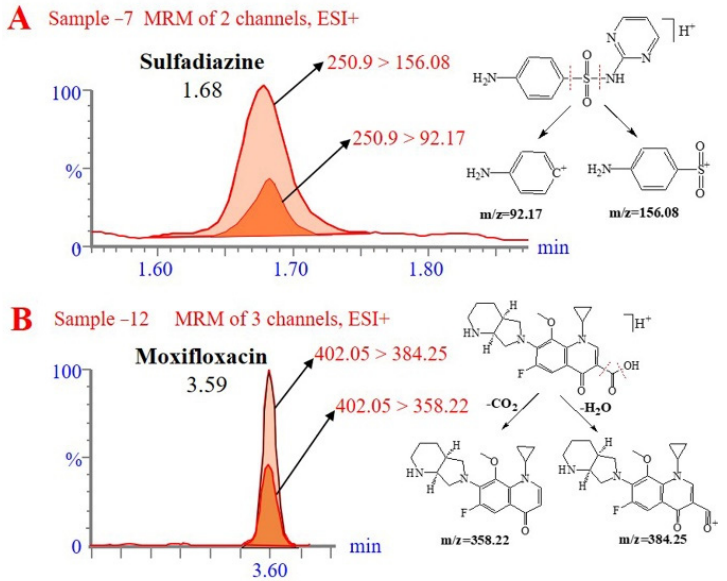
Figure 5. Example chromatograms of antimicrobial drugs (at μ g/kg) detected in samples. ( A ) Sul- fadiazine at 0.6 μ g/kg in sample 7 (ham); ( B ) moxifloxacin at 10.9 μ g/kg in sample 12 (bacon).